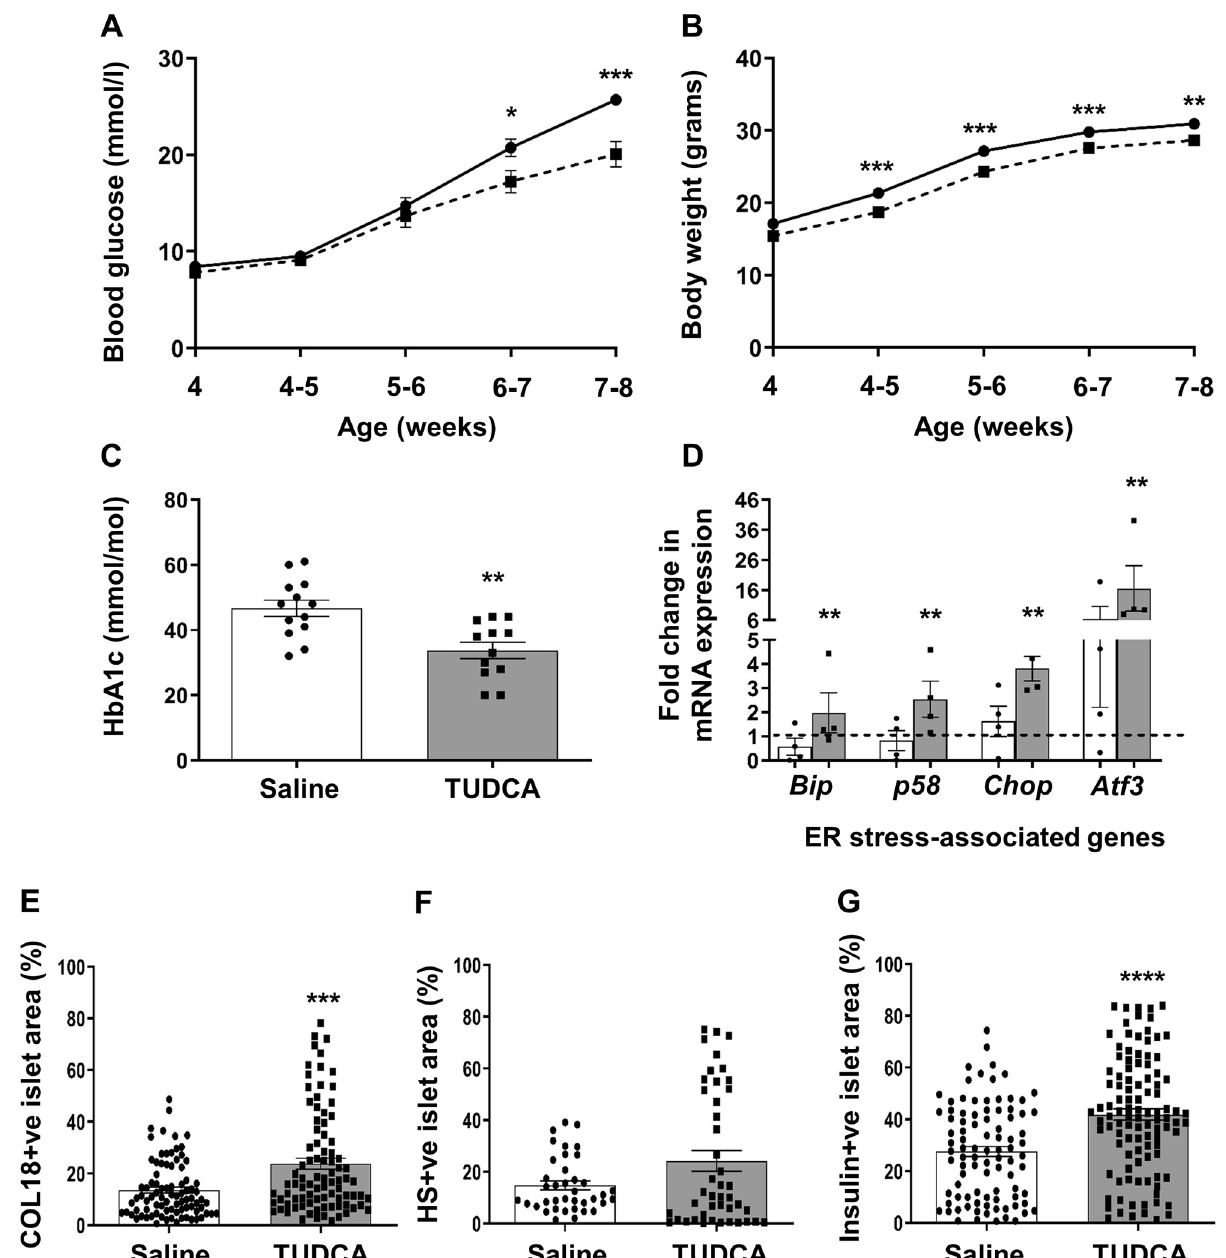
Fig 8. Effect of TUDCA treatment of db/db mice on glycemic control, ER stress-related gene expression and intra-islet COL18 and HS. 4 week old male db/db mice were treated with saline (black line) or TUDCA (150 mg/kg/day; broken line) i.p. for 28 days. ( A ) The non-fasting blood glucose levels and ( B ) body weight were monitored 3x/week. ( C ) HbA1c levels were measured at termination of treatment. ( D ) ER stress-related gene transcripts were analyzed in islets isolated from saline-treated (open bars) and TUDCA-treated (shaded bars) db/db mice. Fold-change refers to mRNA expression relative to gene expression in wt kidney (broken line) which was assigned a value of 1 and normalized to the house-keeping gene Gapdh . The in situ expression of ( E ) HSPG core protein (COL18), ( F ) HS and ( G ) insulin was determined by immunohistochemistry and evaluated as % islet area stained. ( A-B ) Data represent mean weekly measurements ± SEM with n = 12–14 male mice/group, n = 3 measurements/mouse; ( C ) mean ± SEM for n = 12–13 mice/group; ( D ) mean ± SEM, each data point represents an independent experiment, n = 4 mice/group (100–140 islets/donor); ( E-G ) n = 4–9 pancreases/group with n = 86–88 (COL18), n = 38–44 (HS) and n = 92–105 (insulin) islets examined/group. � p < 0.05, �� p < 0.01, ��� p < 0.001, and ���� p < 0.0001, Mann-Whitney